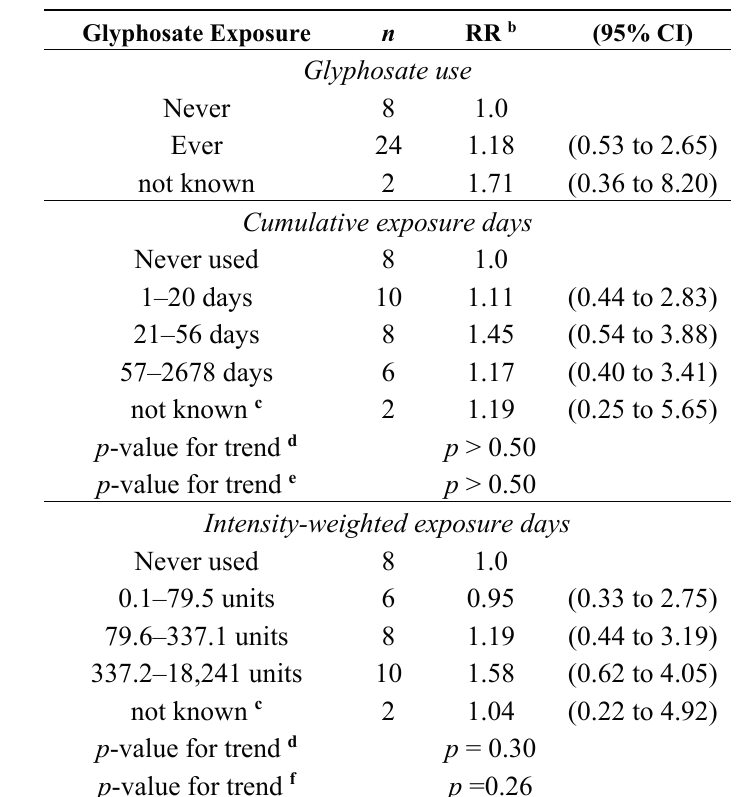
Table 4. Risks of multiple myeloma in relation to estimated glyphosate exposure (ever-use cumulative exposure days or intensity-weighted exposure days) (34 cases (31 males, 3 females) in 55,934 applicators, Set 4 data a